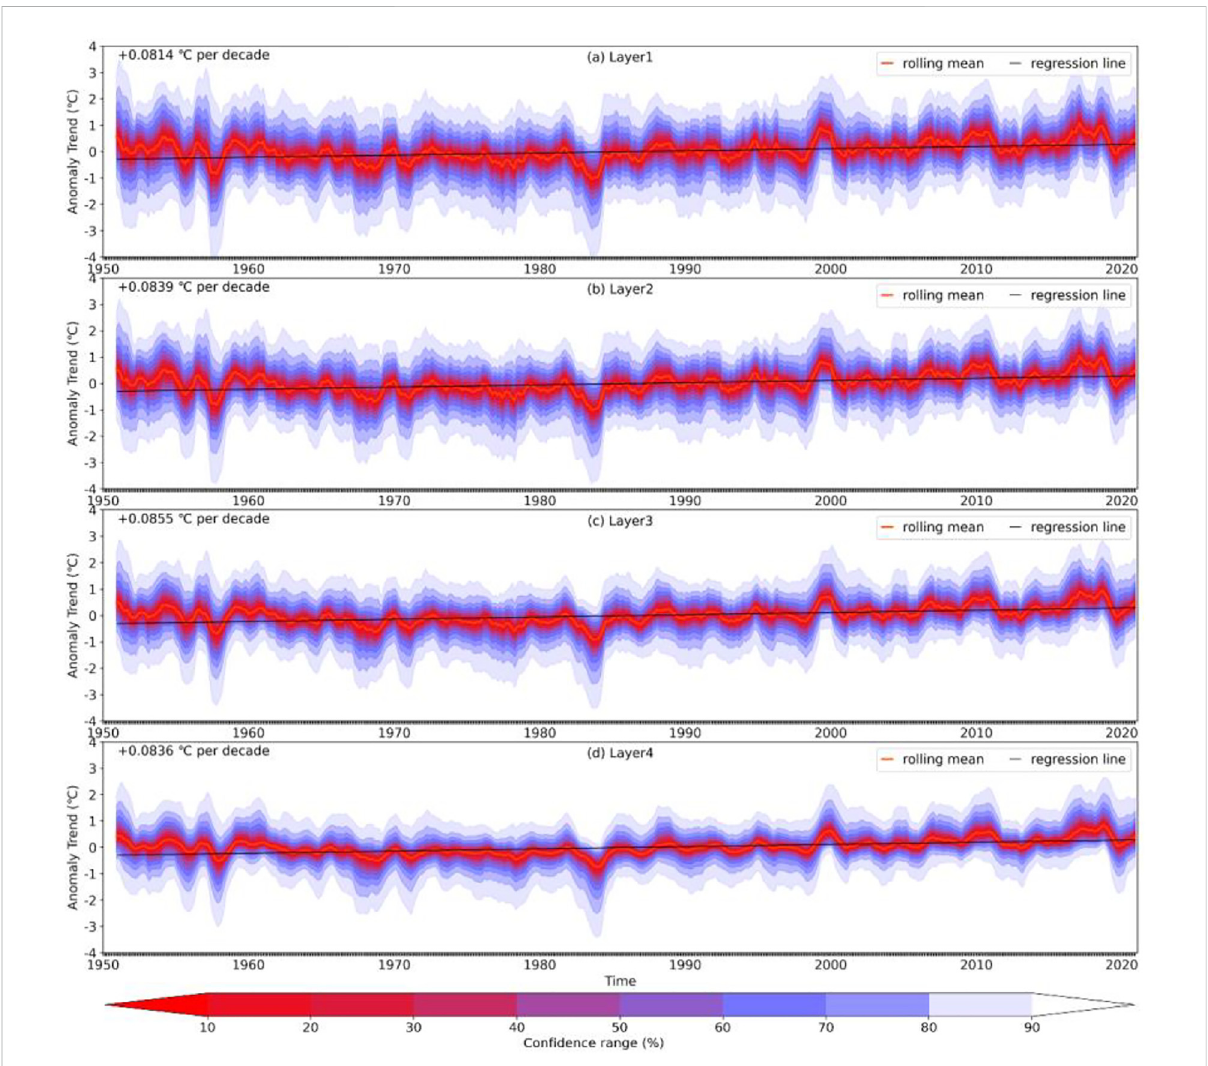
FIGURE 7 The temporal anomaly trend of soil temperature at increasing depth as presented by different layers (A – D) during 1950 – 2020 across the